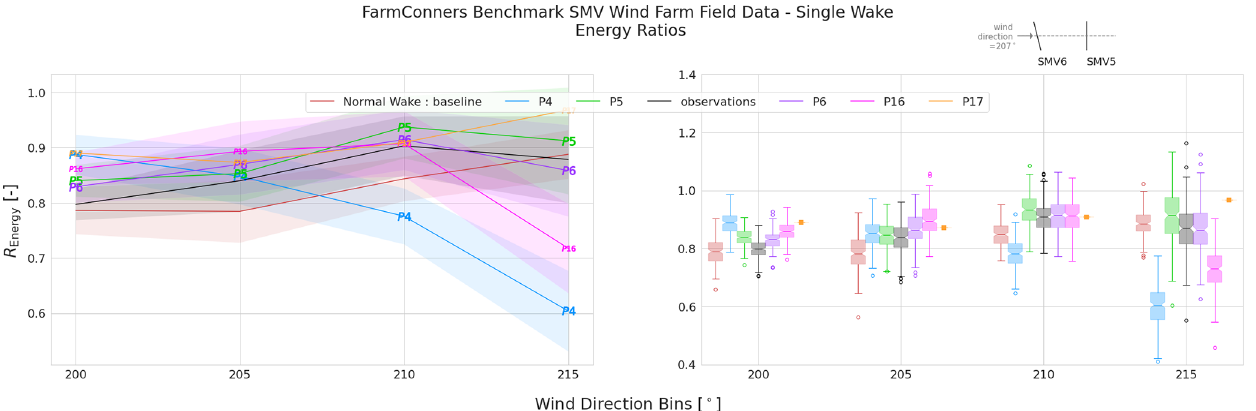
Figure 13. SMV WF field data, single wake under wake steering – energy ratio comparison under wake steering control with − 13.3 ◦ upstream misalignment. Representative layout with corresponding yaw control set point is illustrated at the upper right